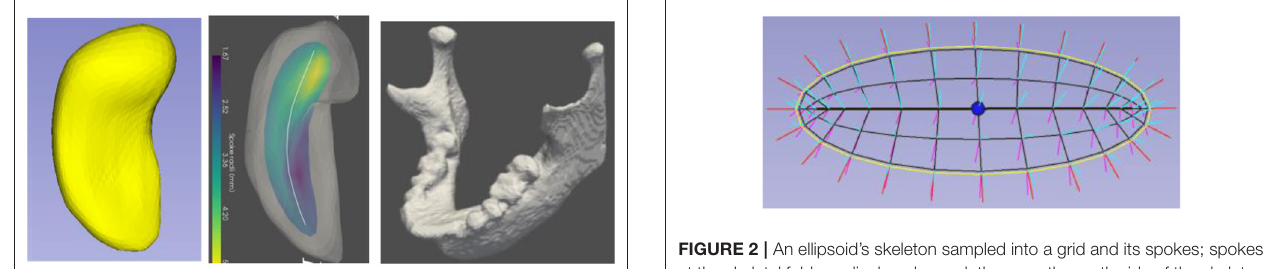
FIGURE 1 | Left: A hippocampus, a C-shaped object. Middle: the hippocampus with its skeletal surface (colored, with the color indicating the width of the object there) and its spine (the curve that is its long axis). Right; a mandible, another C-shaped object.